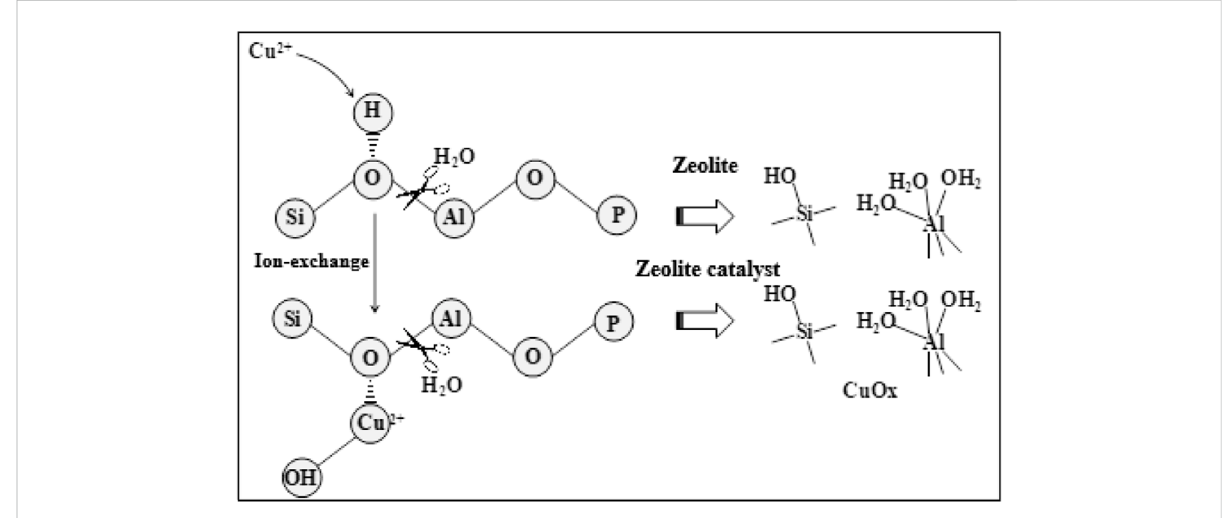
FIGURE 6 Schematic diagram of the destruction of zeolite and its catalyst by low-temperature hydrothermal aging